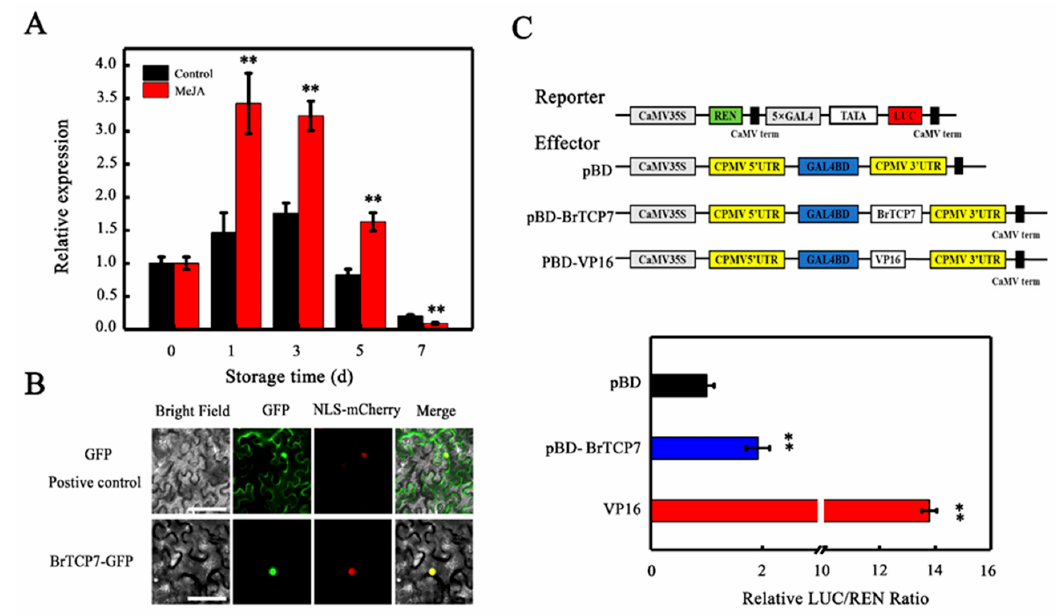
Figure 3. Molecular properties of BrTCP7. ( A ) Relative expression of BrTCP7 in control and MeJA-treated cabbage leaves during senescence. Each value represents the mean ± SD of three biological replicates. Asterisks indicate a significant difference in MeJA-treated leaves compared with control leaves (Student’s t -test: * p < 0.05 and ** p < 0.01). ( B ) Subcellular localization of BrTCP7 in epidermal